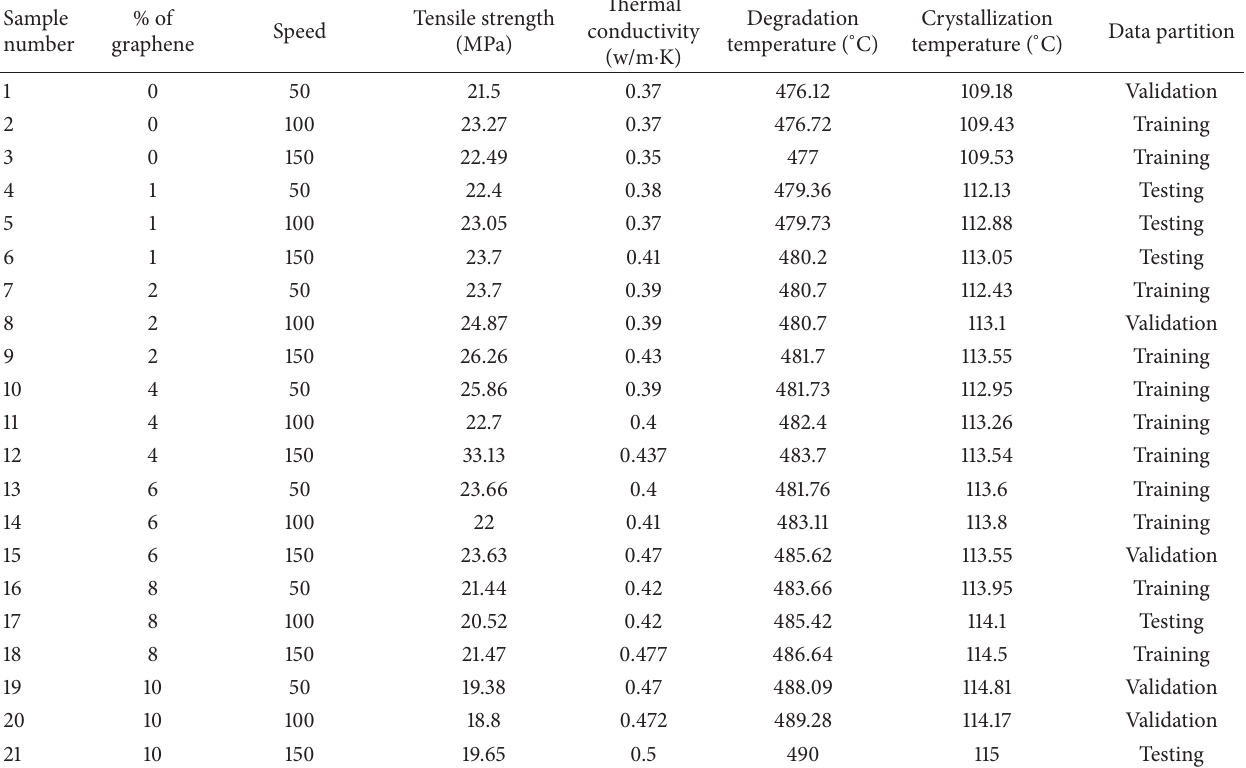
Table 3: Experimental data set.